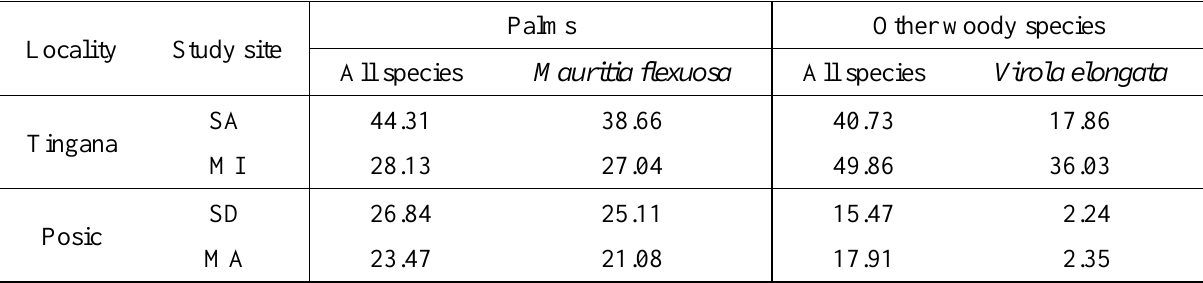
Table 3. Carbon stock (Mg ha -1 ) in palms and other woody species, per plot.